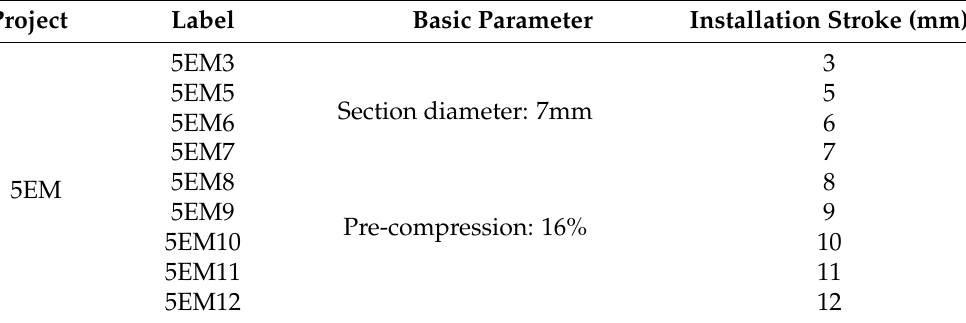
Table A2. Parameters and labels of installation stroke